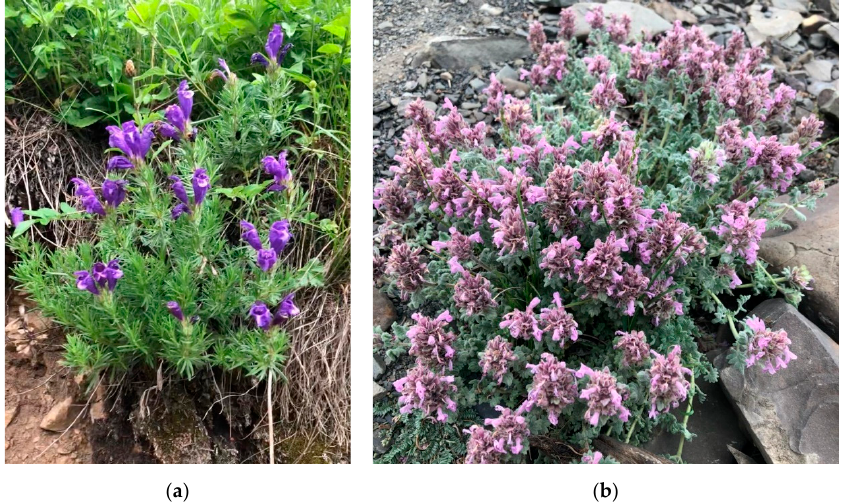
Figure 1. Dracocephalum austriacum ( a ) and D. botryoides ( b ) in their natural habitat in the flowering stage (Azerbaijan, Gryz, Guba region).